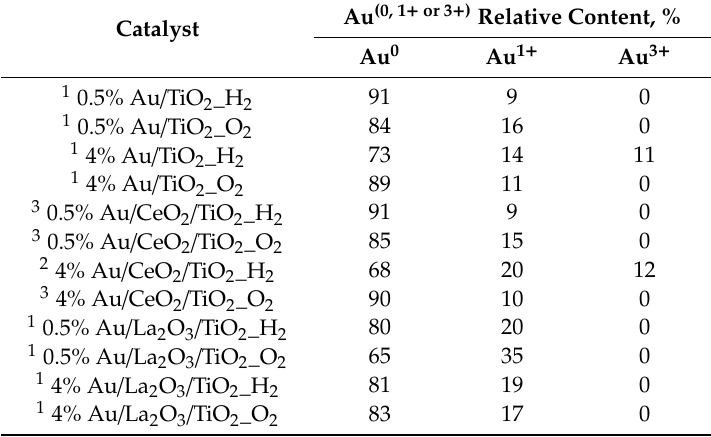
Table 7. Effect of gold content (0.5 or 4 wt.%) and redox treatment (H 2 or O 2 ) on contribution of different electron states of Au calculated according to XPS for Au/TiO 2, Au/CeO 2 /TiO 2 , Au/La 2 O 3 /TiO 2 catalysts.